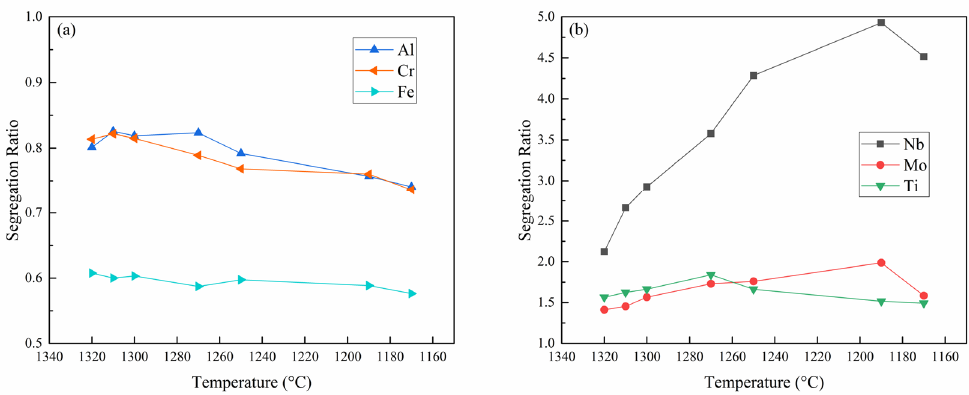
Figure 5. Segregation ratios of solutes at different temperatures: ( a ) Al, Cr, and Fe; ( b ) Ti, Nb, and Mo.